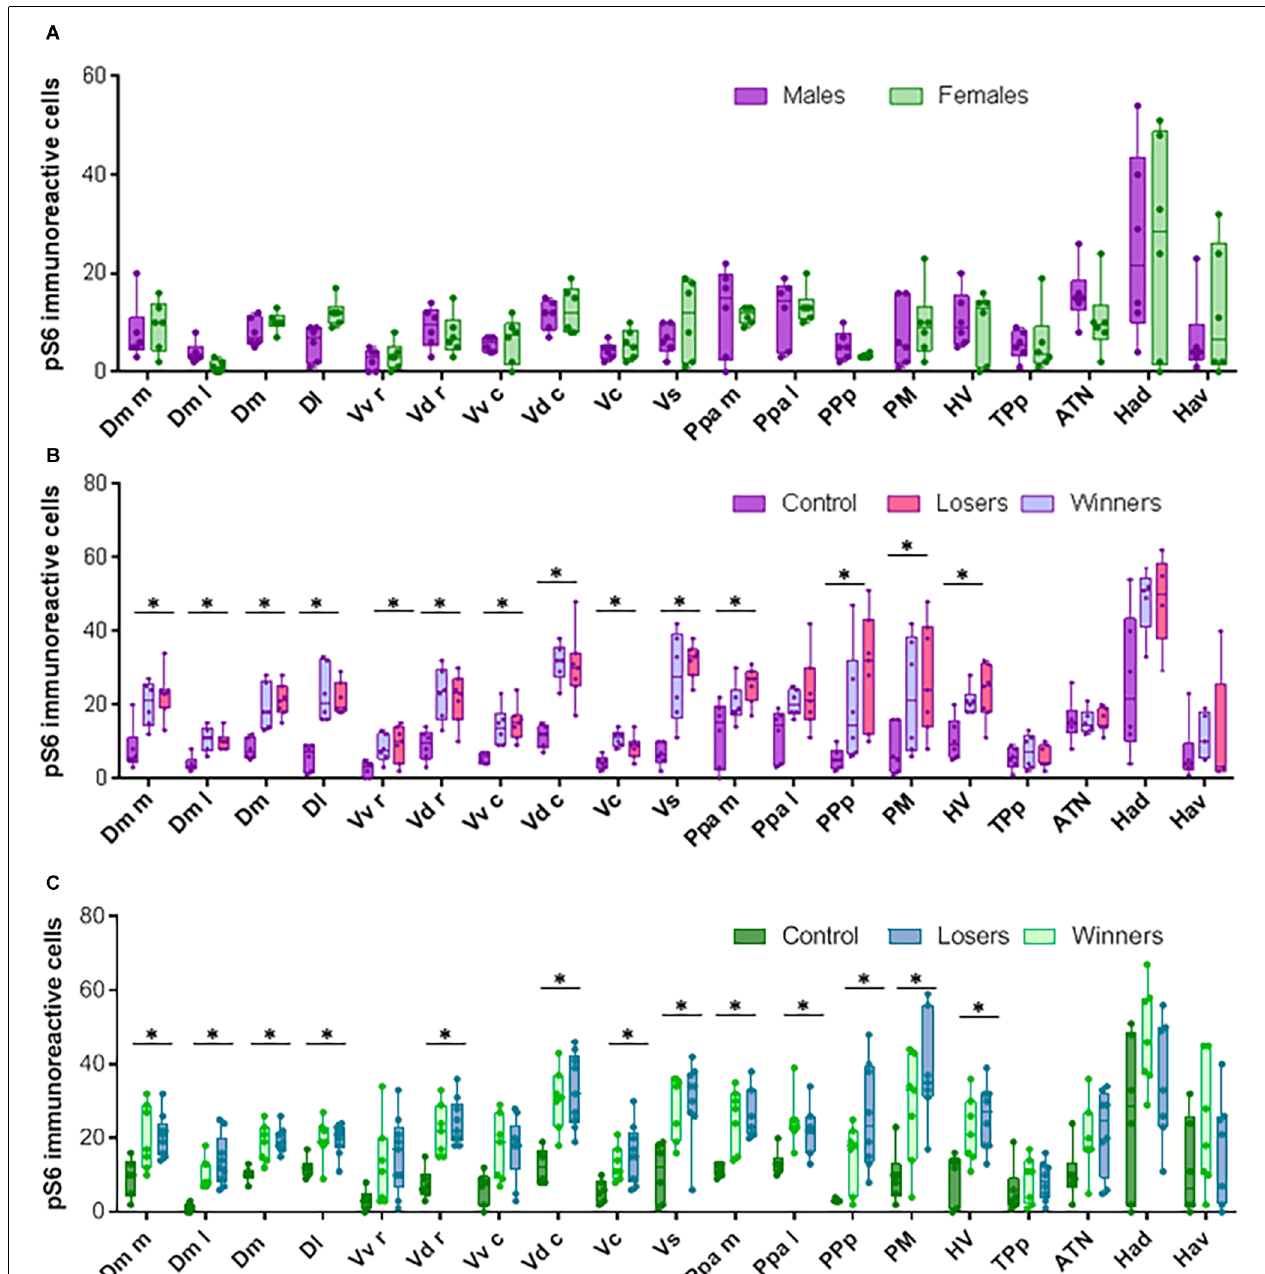
FIGURE 3 | Neural activation in brain areas from the Social decision Making Network after aggressive encounters. (A) pS6 immunoreactive cells in brains from control animals that were not exposed to social interactions. (B) pS6 immunoreactive cells in males. (C) pS6 immunoreactive cells in females. Box plots were used to plot the data: the box extends to the furthest data points within the 25th and 75th percentile, and whiskers extend to the furthest data points not considered outliers. Asterisks indicate significant differences ( p < 0.05) between controls and fish exposed to social interactions using the Kruskal-Wallis test.